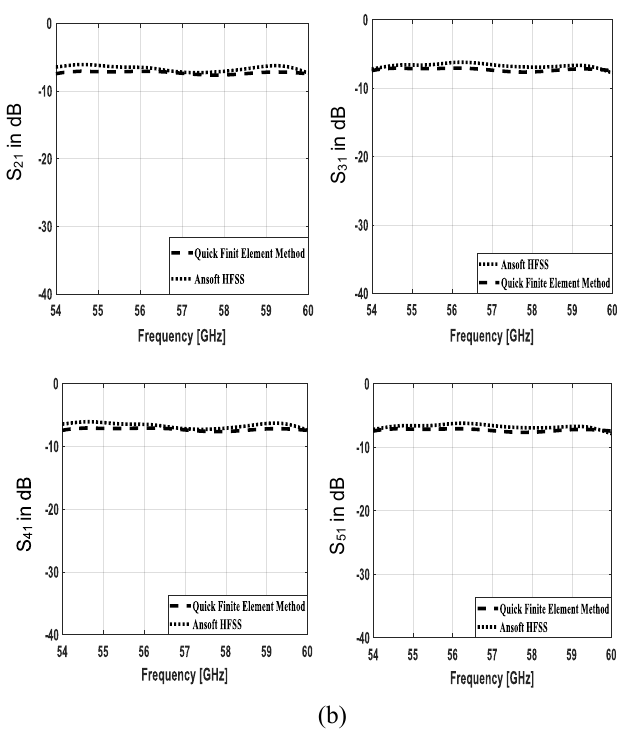
FIGURE 6. Comparison of finite element method simulation results and HFSS for 1x4 power divider. (a) Reflection coefficients S11, (b) Transmission coefficients S12, S13, S14 and S15.